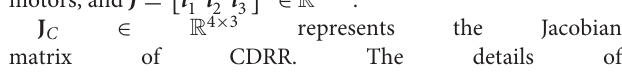
represents the Jacobian matrix CDRR. The details